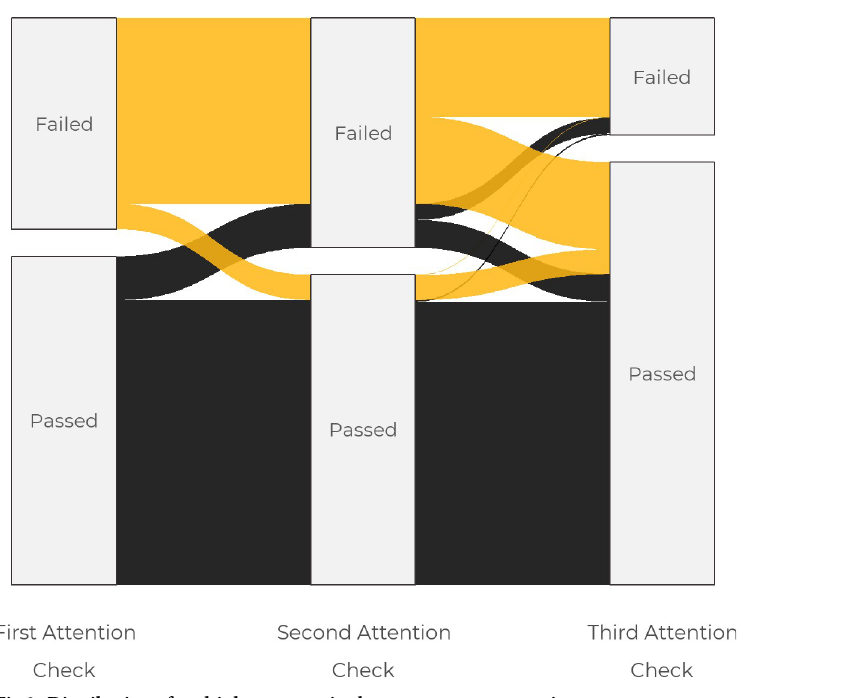
Fig 2. Distribution of multiple attempts in the survey across